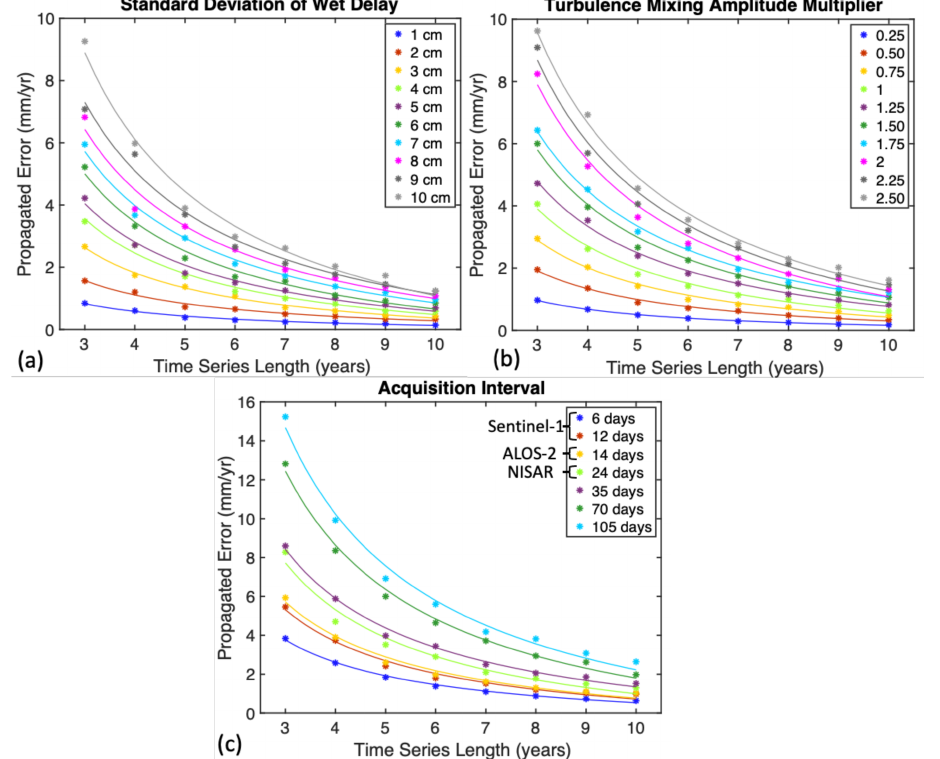
Figure 8. Sensitivity of the estimated detection thresholds with respect to assumed parameters: ( a ) the variation in standard deviation of wet delay calculated from MODIS PWV; ( b ) the scaling parameter for n in Equation (4); and ( c ) the variation in detection thresholds with acquisition intervals of 6, 12, 24, 35, 70, and 105 days. The best-fitting 1/ T trends are plotted using the same color scale. The second sensitivity test was carried out to evaluate the input of turbulence